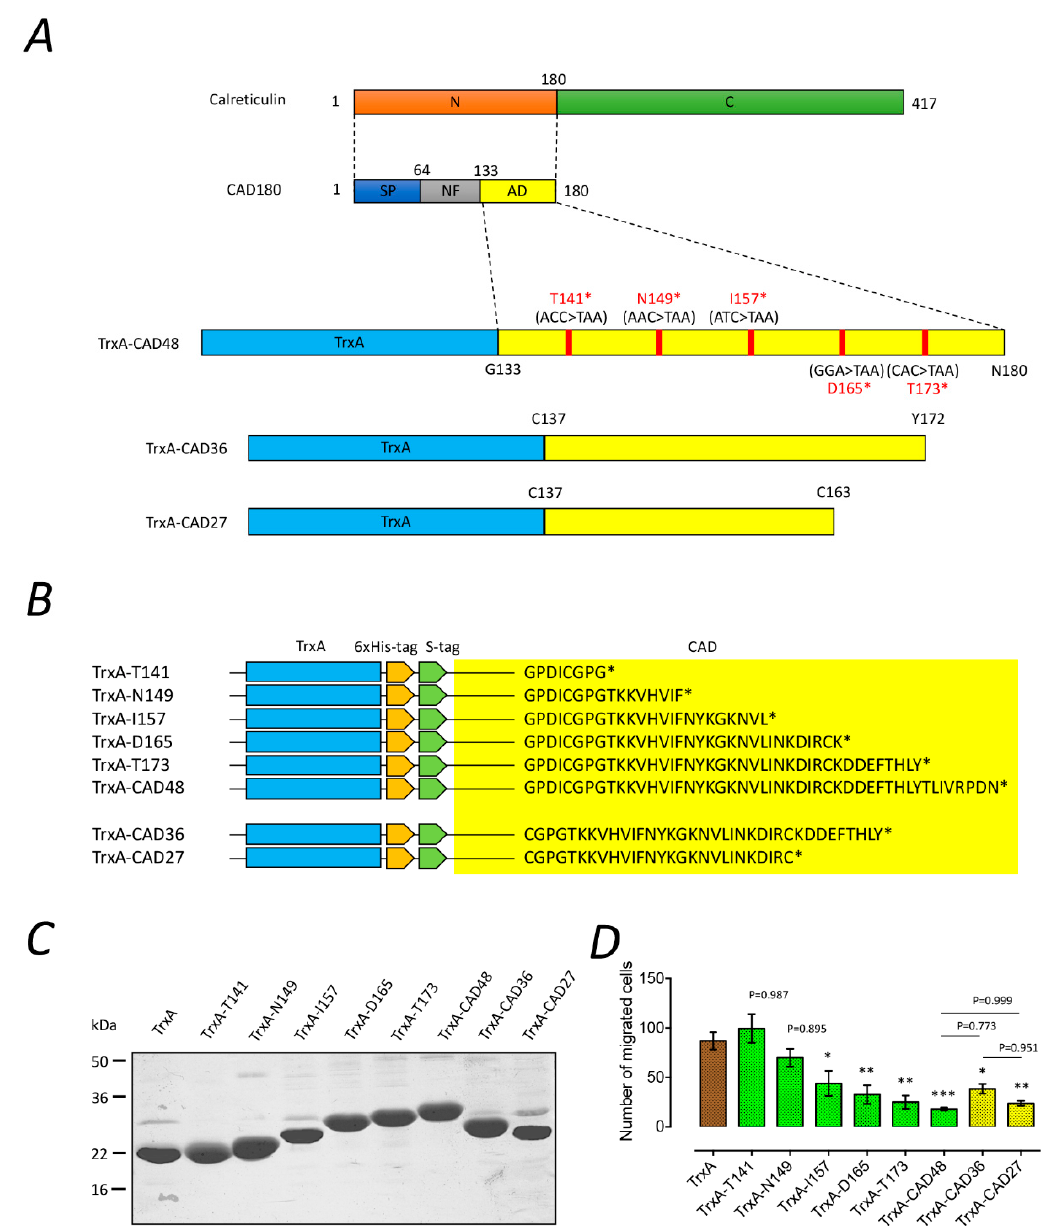
Figure 1. The effect of truncated CAD on the inhibition of angiogenesis. ( A ) Schematic diagram of CAD and its truncated protein constructs. Five truncated CAD fragments derived from CAD48 were generated by introducing a stop codon on each amino acid sequence of T141, N149, I157, D165, and T173. CAD36 (residues C137–Y172) and CAD27 (residues C137–C163) were further generated according to the functional motif of CAD48 and can form in a cyclic structure. N: N-terminal domain. C: C-terminal domain. SP: Signal peptide. NF: Nonfunctional domain. AD: anti-angiogenic domain. ( B ) Amino acid sequence of TrxA-CAD recombinant proteins. The yellow square box indicates truncated CAD fragments. * Stop codon. ( C ) Purification and SDS-PAGE analysis of the recombinant fragments of truncated CAD. ( D ) Effects of the CAD48 and its truncated fragments (green and yellow bars) on migration of primary human endothelial cells (HUVECs). The quantification of migration assay characterizing migrated cells and data are presented as the mean ± SEM ( n = 3). Statistical analysis between groups was performed using one-way ANOVA followed by Tukey’s multiple comparisons test (* p < 0.05, ** p < 0.001, *** p < 0.0001).